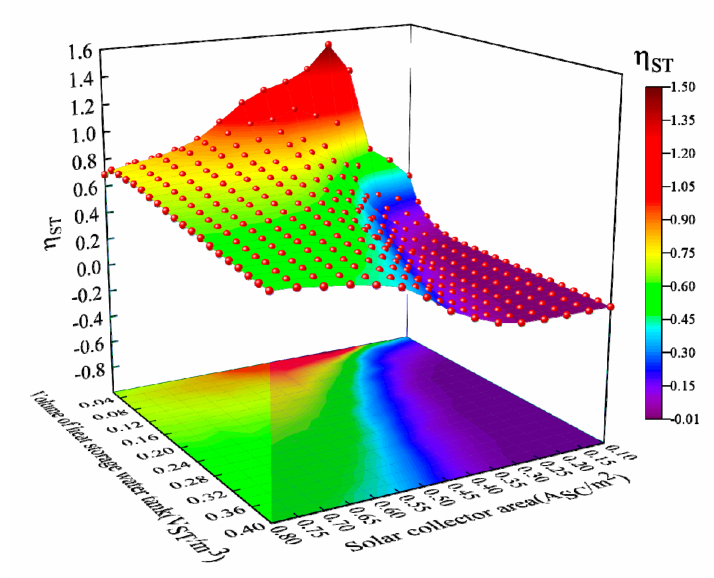
Figure 12. Diagram of η ST changes as A SC and V ST